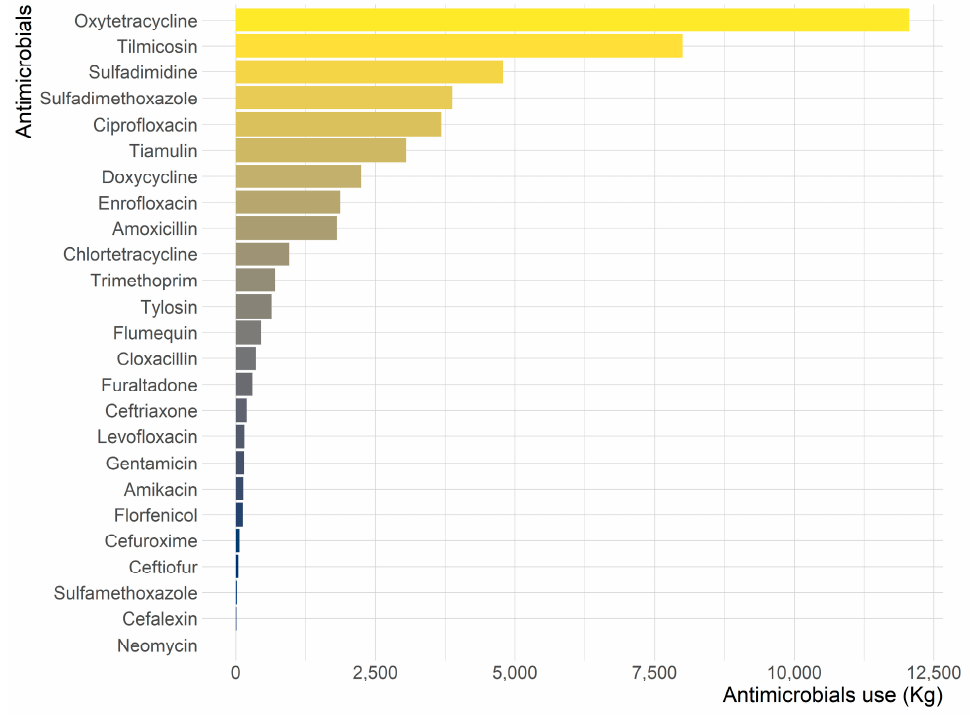
Figure 1. Antimicrobials quantities (by antimicrobial agents) reported for use in veterinary medicine in Nepal in 2020.